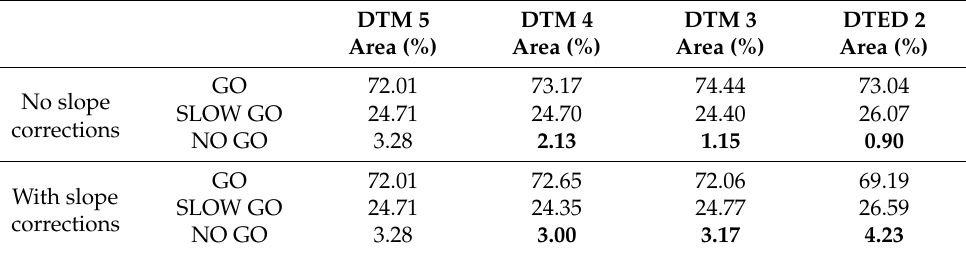
Table 6. The comparison of the extent of passable, hardly passable, and impassable areas with different elevation models (DTM 5, DTM 4, DTM 3, DTED 2) without slope corrections and with slope corrections. Location: Kdynˇe, 6 km × 6 km, moist conditions, GO max slope = 10 ◦ , SLOW GO max slope = 20 ◦ . The main improvements in the results are displayed as bold values.